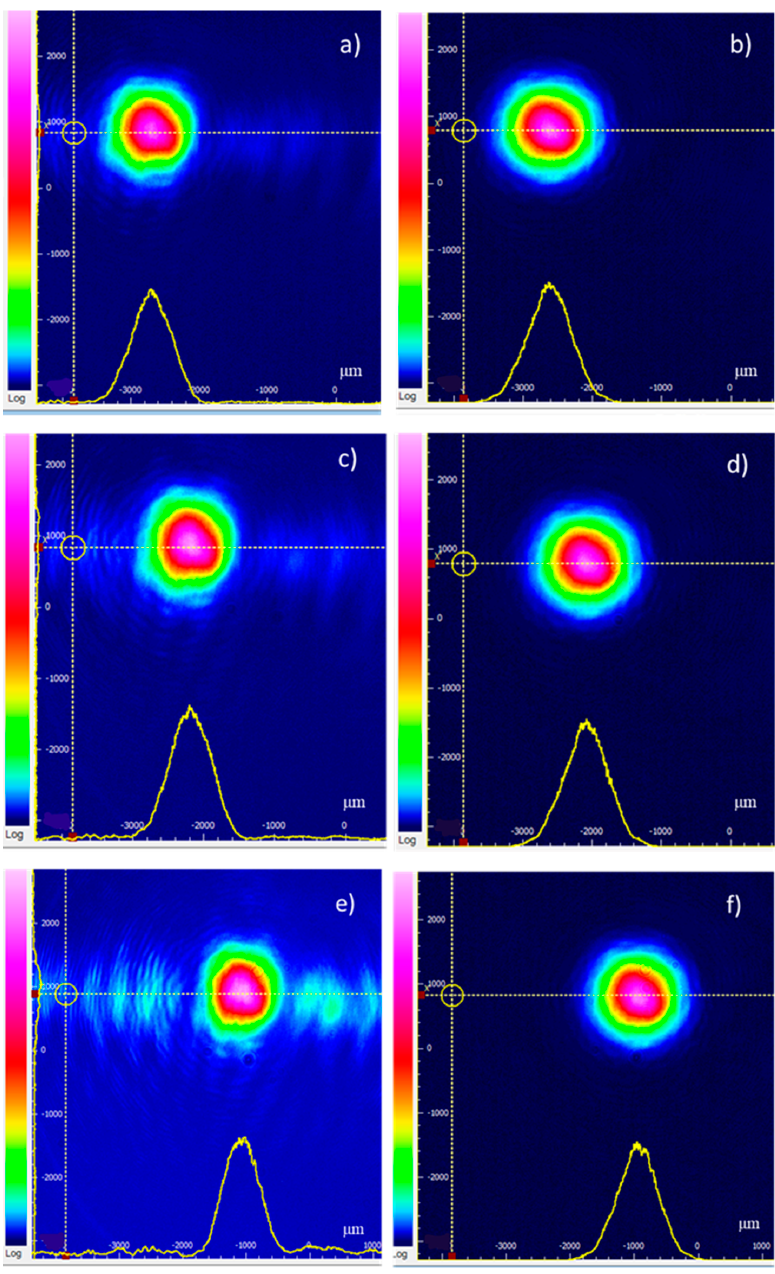
Figure 16. Measured intensity profiles of the reflected beams from the Ni grating with the period Λ = 400 nm and the depth h = 80 nm at the distance z = 11 cm. ( a , b ) θ ( c , d ) θ i = 32.17 ◦ , ∆ x = − 115 µ m; ( e , f ) θ i = 32.50 ◦ , ∆ x = − 181 µ m. Left column— p -polarization; right column— s